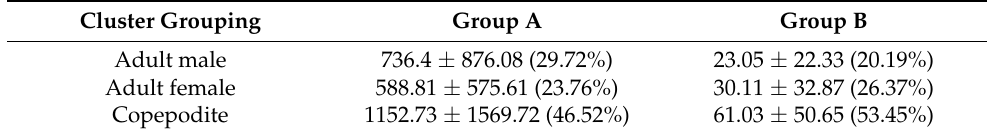
Table 2. Composition of grouping results by cluster analysis, where numbers show abundance (inds. m − 3 , mean ± SD) and their proportion (%) in